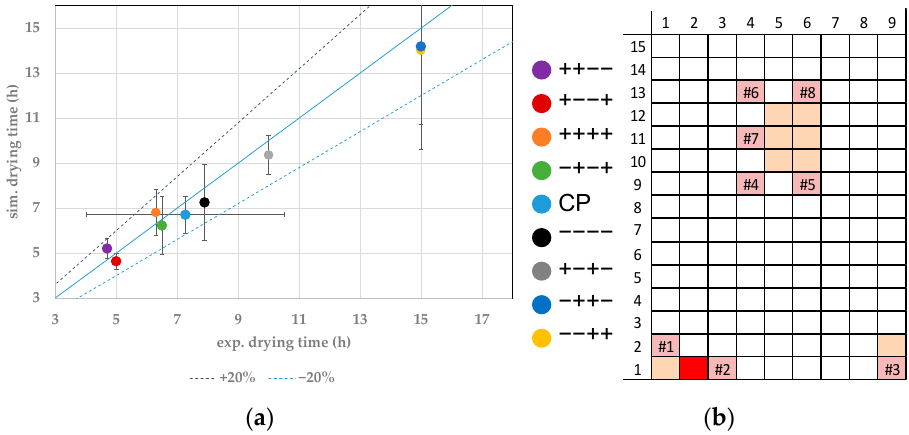
Figure 5. ( a ) Parity plot between simulated and experimental primary drying endpoints for vial 1.2. ( b ) Color legend for experiments and vial position (red: shown vial, orange: other probed vials, pink: WTMplus sensor position and WTMplus number).